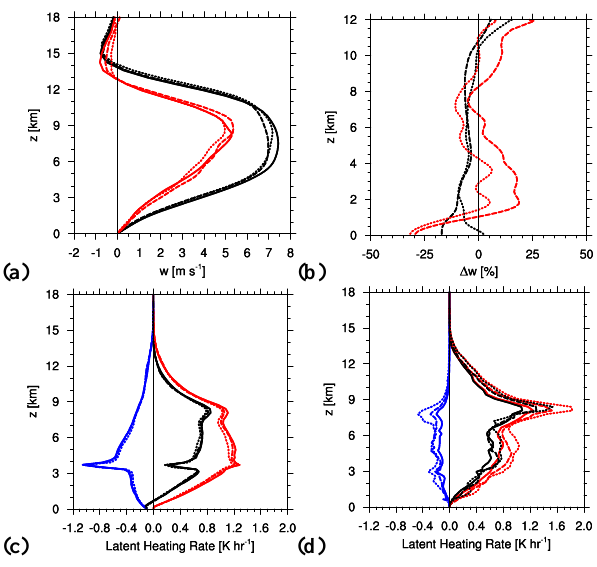
Fig. 7. (a) Average of the vertical velocity profile within the con- vective core and (b) the change in the mean vertical velocity due to changes in CCN number concentration. The convective core is defined to contain the columns in which the mean vertical ve- locity is more than 1ms − 1 . Bulk (black) and bin (red) are dis- played on the same graph. The differences are performed for the “Semi-Polluted” (dashed) and “Polluted” (dotted) cases relative to the “Clean” (solid) case. (c) and (d) show the latent heating rates for the bulk and bin model simulations, respectively. The net heating rate (black) is separated into warming (red) and cooling (blue). The vertical axes are different so as to highlight the differences within the cloud itself and because the relative differences at cloud top and above are much larger than those within the cloud. Simulation time is shown in the